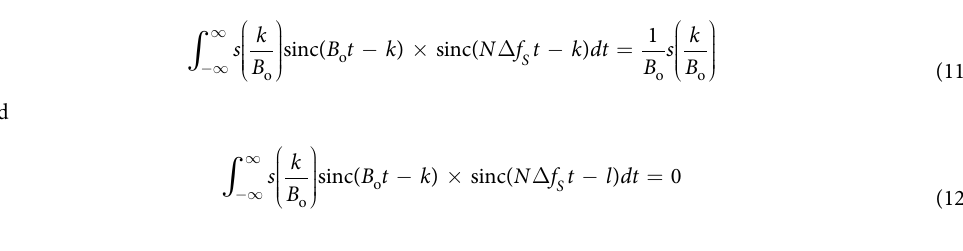
The bandwidth of this signal in the optical domain is B o and correspondingly its baseband width B o /2. Since sinc functions are orthogonal, it can be shown that: